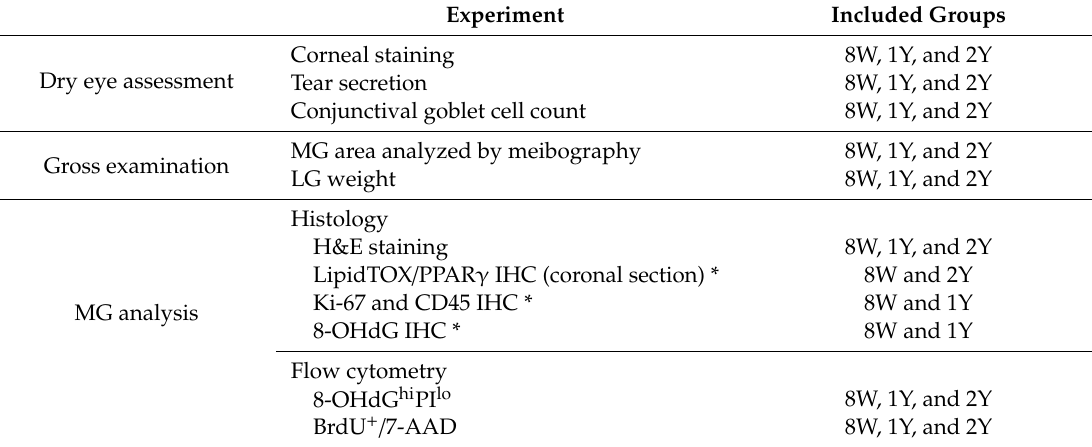
Table A2. List of groups included in each experimental